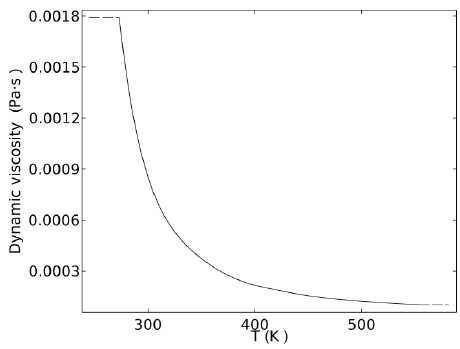
Figure 7. The dynamic viscosity of the water changes with temperature.